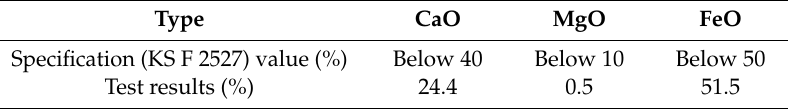
Table 5. Chemical composition of steel slag.